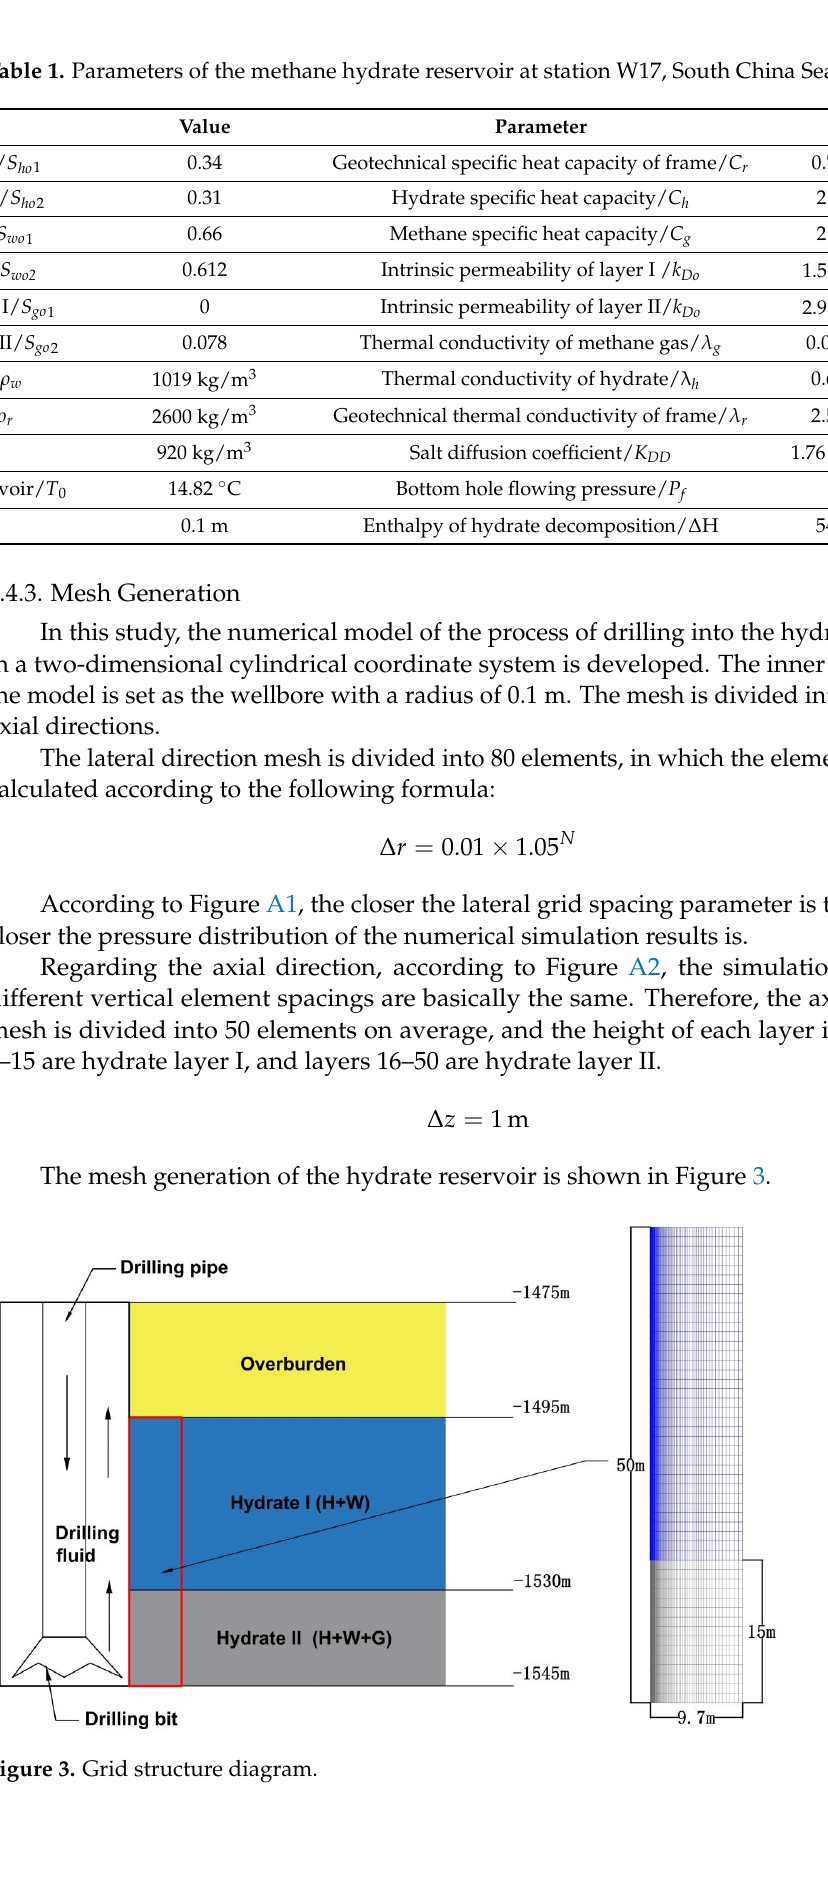
Table 1. Parameters of the methane hydrate reservoir at station W17, South China Sea.